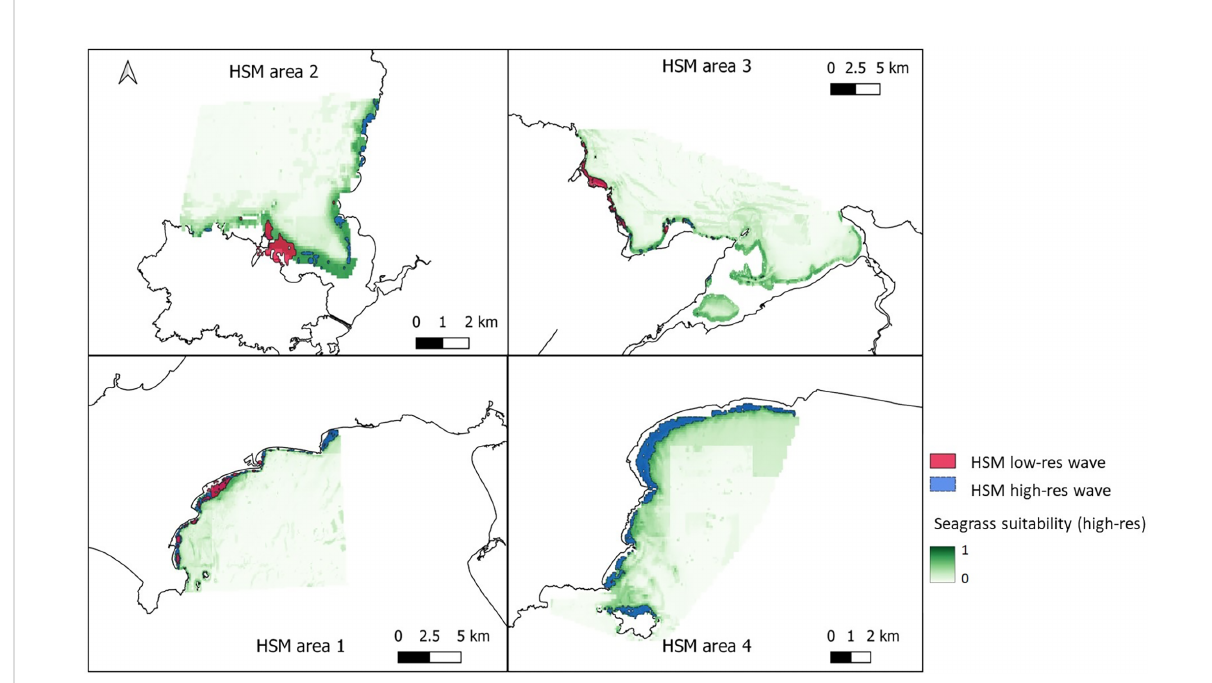
FIGURE 6 Areas of suitable seagrass habitat in green for the four chosen areas around Wales. Top left – West Anglesey (area 2), top right – East Anglesey (area 3), bottom left – Llyn Peninsula (area 1), bottom right – Pembrokeshire (area 4). Maps shows results from ensemble model of 6 methods, using presence only data and all the non-colinear variables including high-resolution wave height data. Overlayed is the vector layer outputs when a threshold of >0.6 probability was applied to the model with low resolution wave data model (pink) and high-resolution wave data model (blue) for comparison.